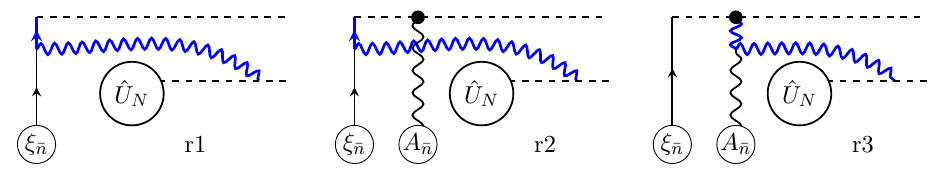
Figure 7 . The rapidity divergent diagrams for operator U 1 (r1), and operator U 2 (r2,r3) that interacts with any other semi-compact operator U Wilson lines are indicated as dashed. The black dots are insertions of F